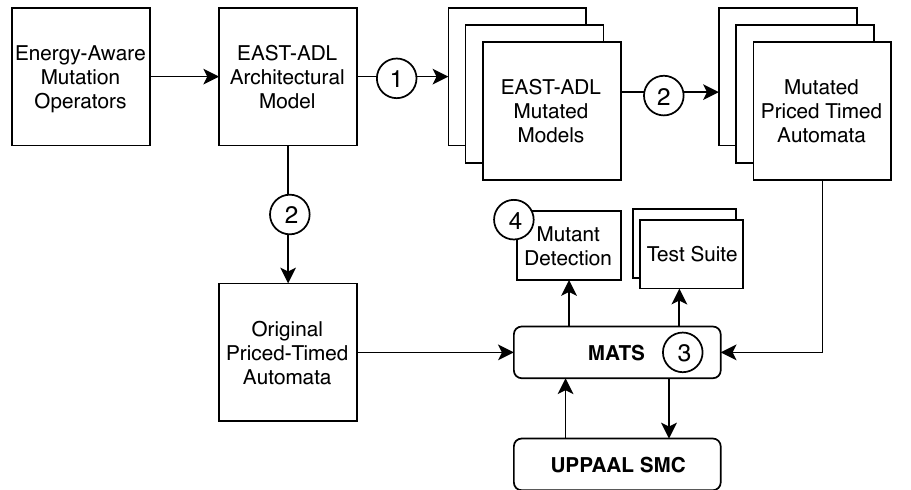
Figure 1. An overview of the test suite generation and evaluation method for energy consumption based on Electronic Architecture and Software Tools Architecture Description Language (EAST-ADL) architectural models and mutation